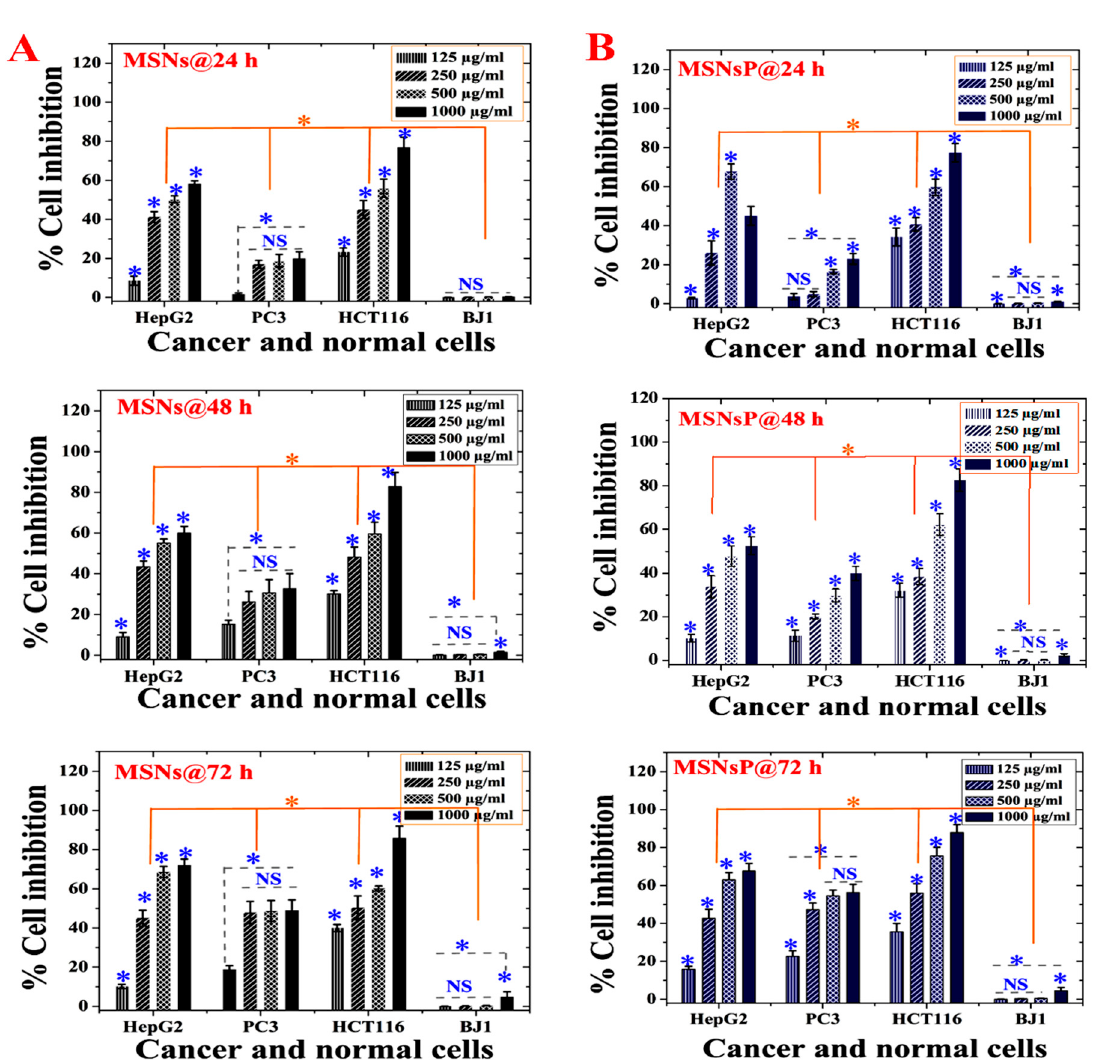
Figure 5. In vitro cytotoxicity (as percent inhibition) of MSNs and MSNs functionalized with phosphonate functional groups (MSNsP) for biocompatibility evaluations in cancer and normal cell lines after 24, 48, and 72 h of incubation with cancer cells (liver, HepG2; prostate, PC3; and colon, HCT116) and normal fibroblasts (BJ1). ( A ) Cytotoxicity of MSNs towards cell lines. ( B ) Cytotoxicity of MSNsP towards cell lines. Note: A blue asterisk (*) indicates significant ( p < 0.05) differences between tested concentrations, whereas an orange asterisk (*) indicates significant differences between cell lines. NS, not significant. All data are expressed as mean ± SD.